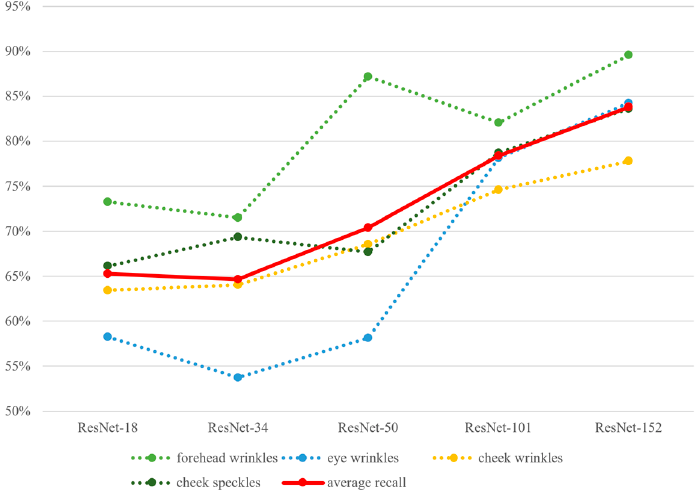
Figure 14. Results of classification precision (from K-fold cross validation) plotted against model layers and facial features.